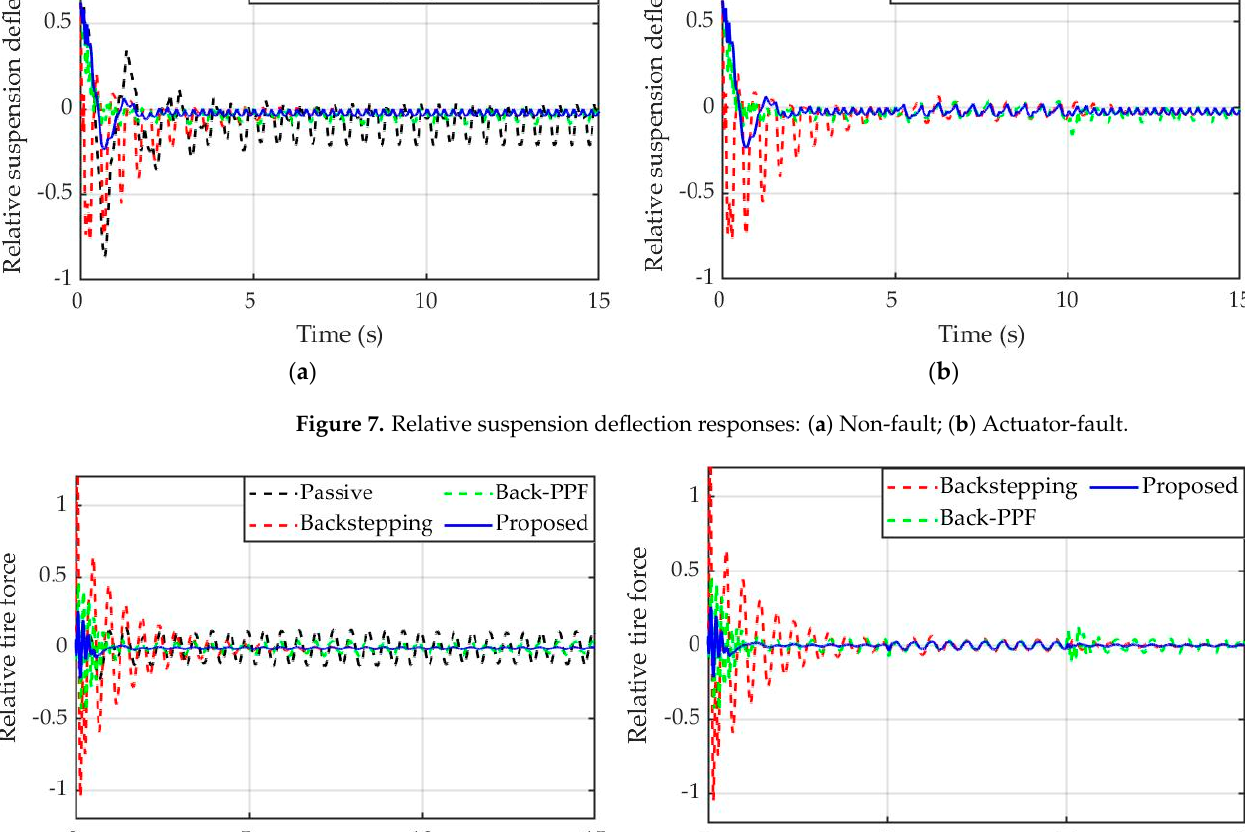
Figure 6. Sprung mass angular acceleration: ( a ) Non-fault; ( b ) Actuator-fault.